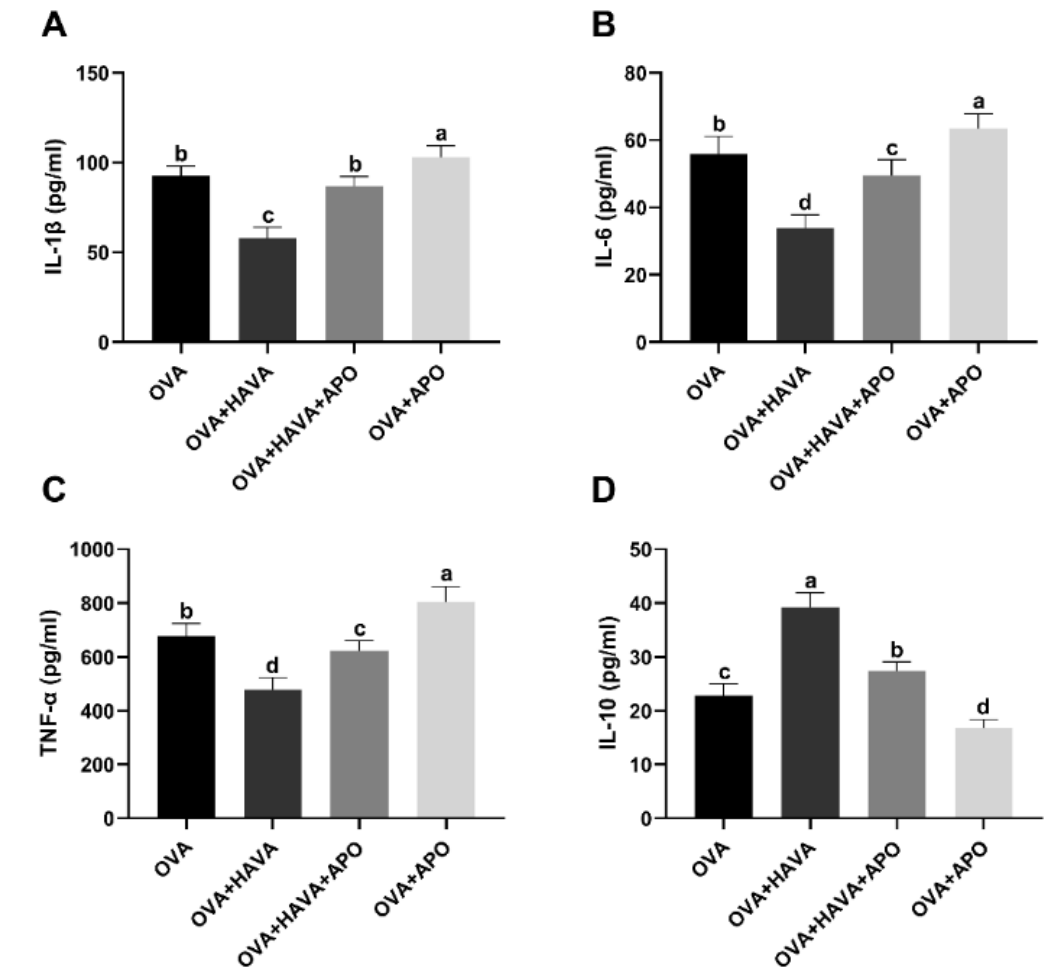
Figure 6. The heat shock protein 70 (Hsp70) inhibition weakened the anti-inflammatory effect of avenanthramide (AVA) in ovalbumin (OVA)-induced food allergy mouse model in experiment 2. ( A – C ) Pro-inflammatory cytokines including interleukin-1 β (IL-1 β ), IL-6 and tumor necrosis factor- α (TNF- α ) in the serum, ( D ) the anti-inflammatory factor IL-10 in the serum. OVA: mice orally challenged with OVA; OVA + HAVA: an OVA challenged group that was oral gavaged with a high dose of 20 mg/kg bw avenanthramide (AVA); OVA + HAVA + APO: the OVA + HAVA group coupled with apoptozole (APO); OVA + APO: the OVA group coupled with APO. Results are presented as means ± SDs ( n = 8). Bars with no letter in common are significantly different, p ≤ 0.05. Allergic and inflammatory responses under Hsp70 inhibition were also assessed in the jejunum in OVA-induced allergic mice (Table 2). Consistently, compared with the OVA group and the OVA + HAVA + APO group, levels of IL-4 and TNF- α in the jejunum were decreased ( p ≤ 0.01) in the OVA + HAVA group, while concentrations of IL-10 and TGF- β were increased ( p ≤ 0.01) in the OVA + HAVA group. The concentrations of IL-25, IL-33 and sIgA in the jejunum were higher ( p ≤ 0.01) in the OVA + HAVA group than the OVA group and the OVA + HAVA + APO group. Additionally, the levels of IL-4 and TNF- α in the jejunum were lower ( p ≤ 0.01) in the OVA + HAVA + APO group than the OVA group and the OVA + APO group, while the concentrations of IL-10, TGF- β , IL-25, IL-33, and sIgA in the jejunum were higher ( p ≤ 0.01) in the OVA + HAVA + APO group than the OVA group and the OVA + APO group. The concentrations of TSLP in the jejunum were not different ( p > 0.05) among the four groups in experiment